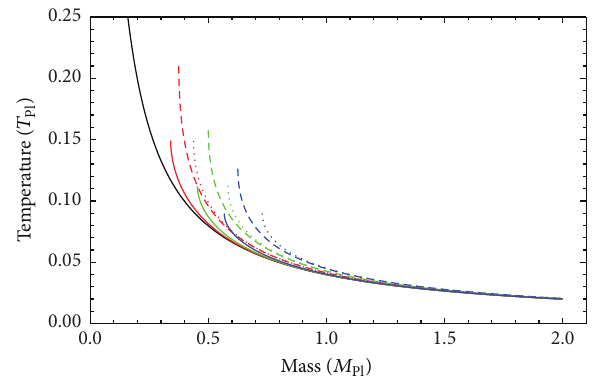
Figure 1: The temperature versus the black hole mass for the case 𝑛 = 2 . From left to right: the Hawking result (black solid curve), GUP 2 result (solid curve), GUP 0 result (dashed curve), and GUP 1 result (dotted curve) for 𝛼 = 0.75 (red), 𝛼 = 1 (green), and 𝛼 = 1.25 (blue), respectively.